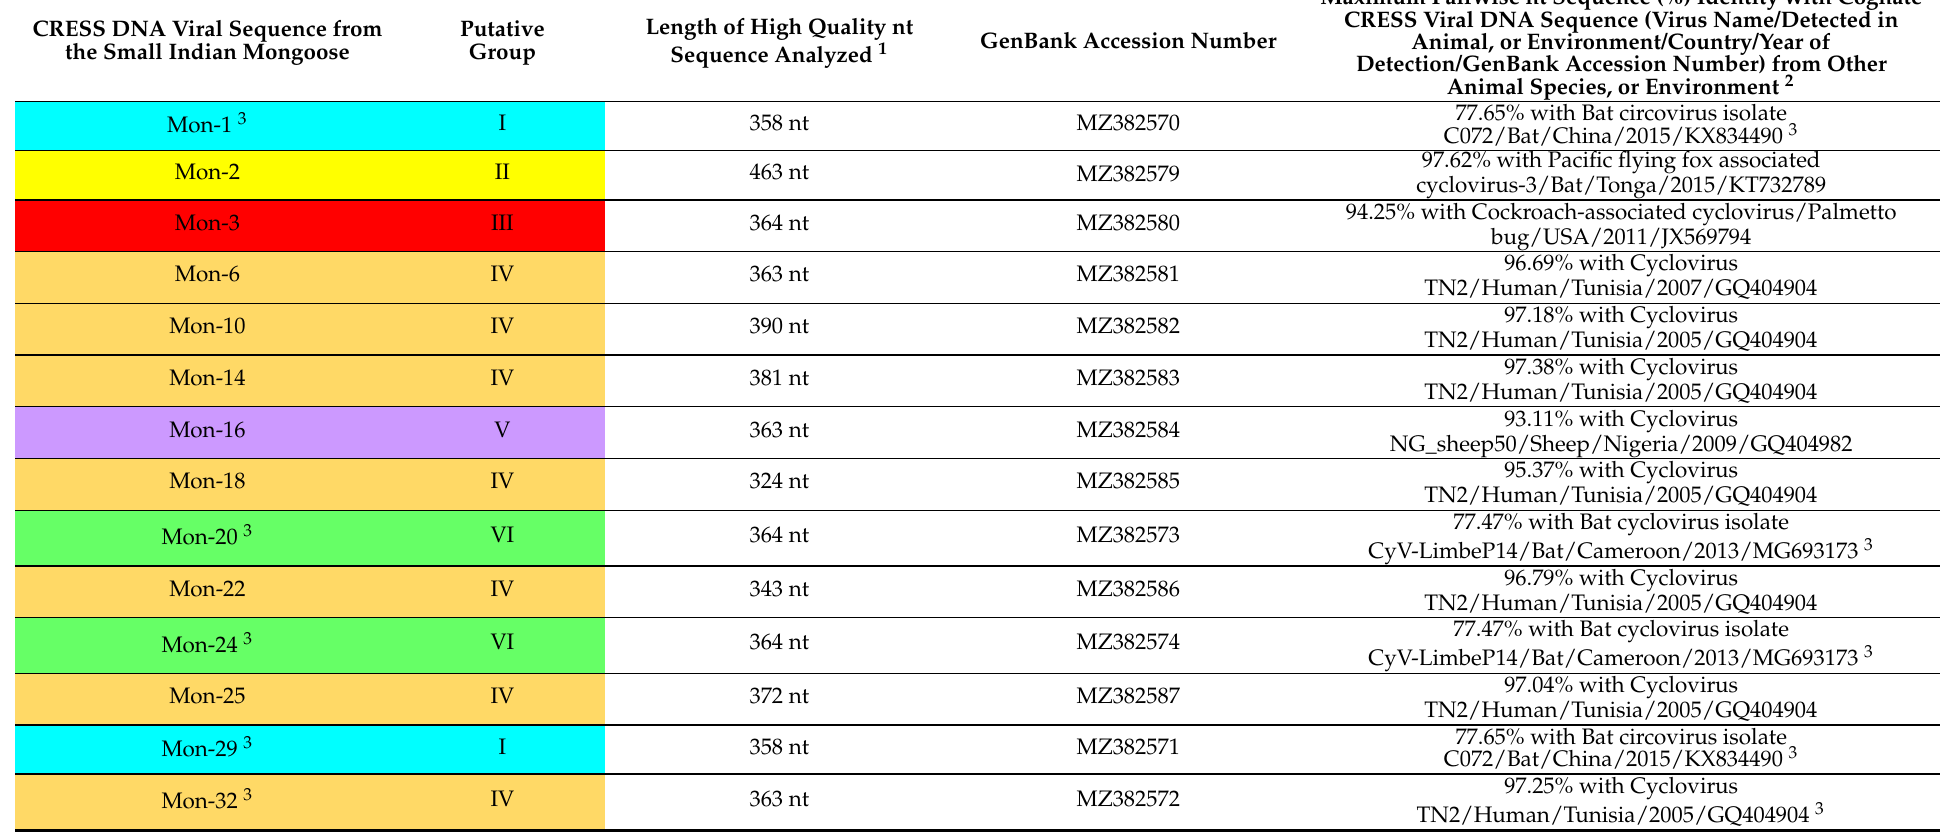
Table 1. Pairwise identities of partial circular Rep-encoding single-stranded (CRESS) DNA viral sequences detected in the small Indian mongoose ( Urva auropunctata ) with those reported from other animal species/environmental samples. Based on BLASTN analysis and pairwise nucleotide (nt) sequence identities, the mongoose associated partial CRESS DNA viral sequences were classified into at least 8 putative groups (designated as I–VIII). Mongoose associated viral sequences sharing >95% nt sequence identities between themselves were assigned to the same group and are highlighted with the same